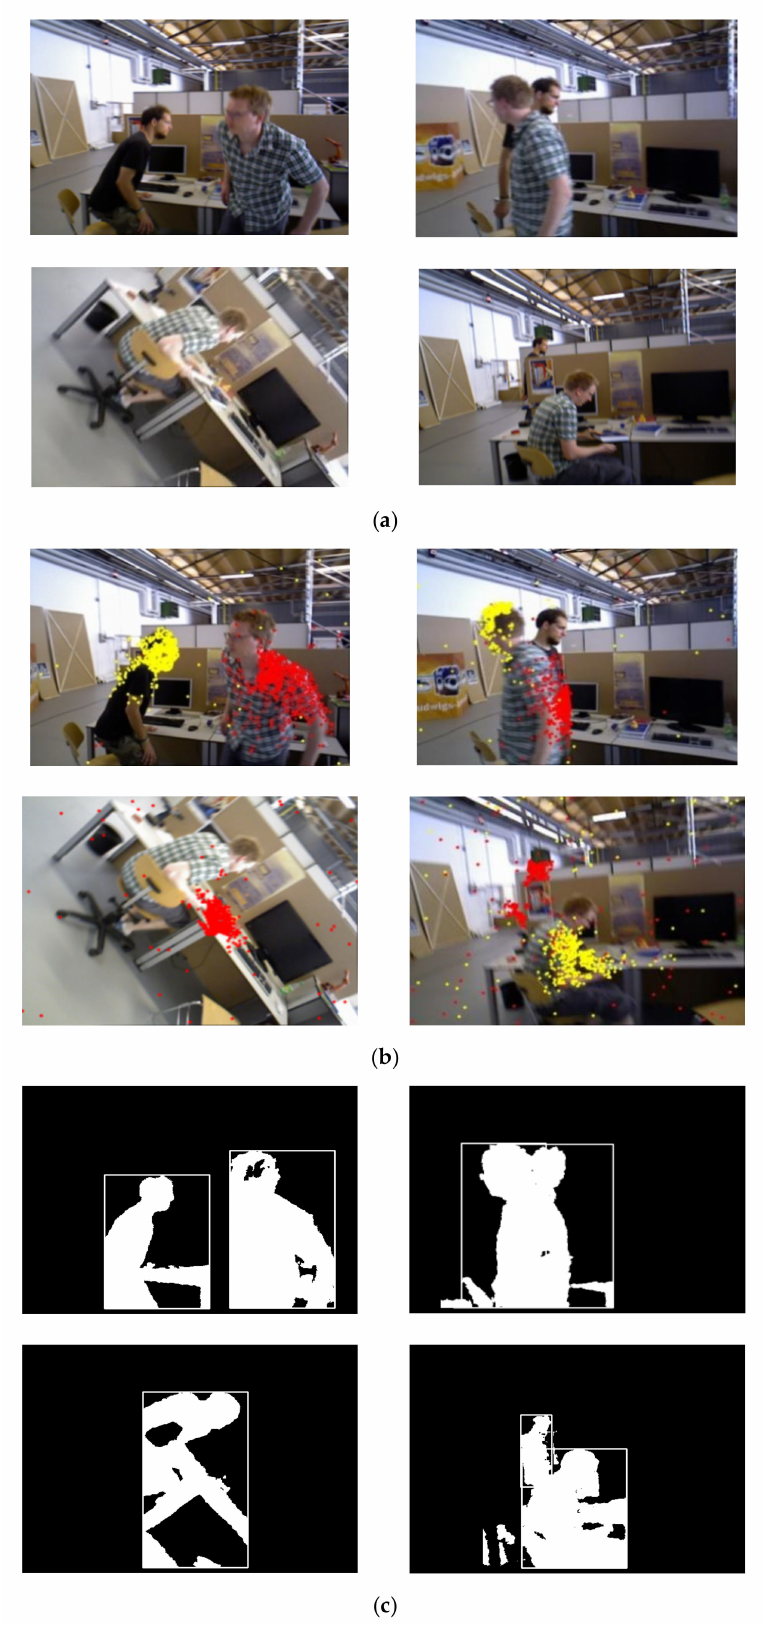
Figure 7. The segmentation and tracking results of dynamic objects using particles on the image sequence “ fr3_walking_half_sphere ”. ( a ) The raw RGB image examples; ( b ) The tracking results; ( c ) The segmentation results of dynamic